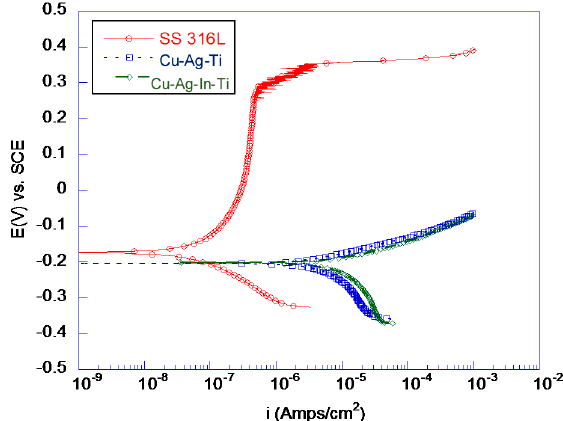
Figure 5. Potentiodynamic polarization scans conducted on brazes (blue and green traces) and a 316L stainless steel sample (red trace) in 0.6 M NaCl. The scan rate for all testing was 0.166 mV/s.